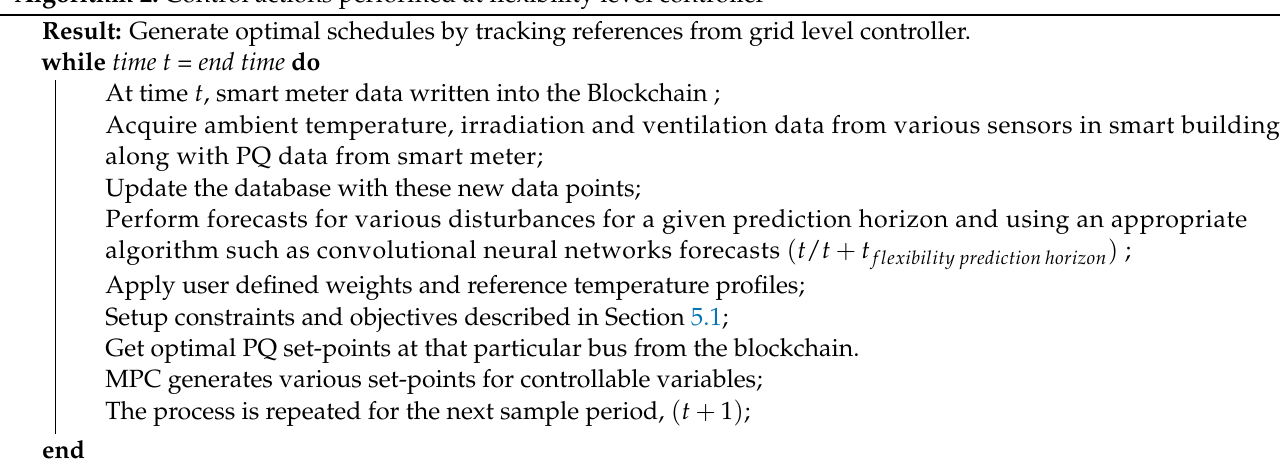
Algorithm 2: Control actions performed at flexibility level